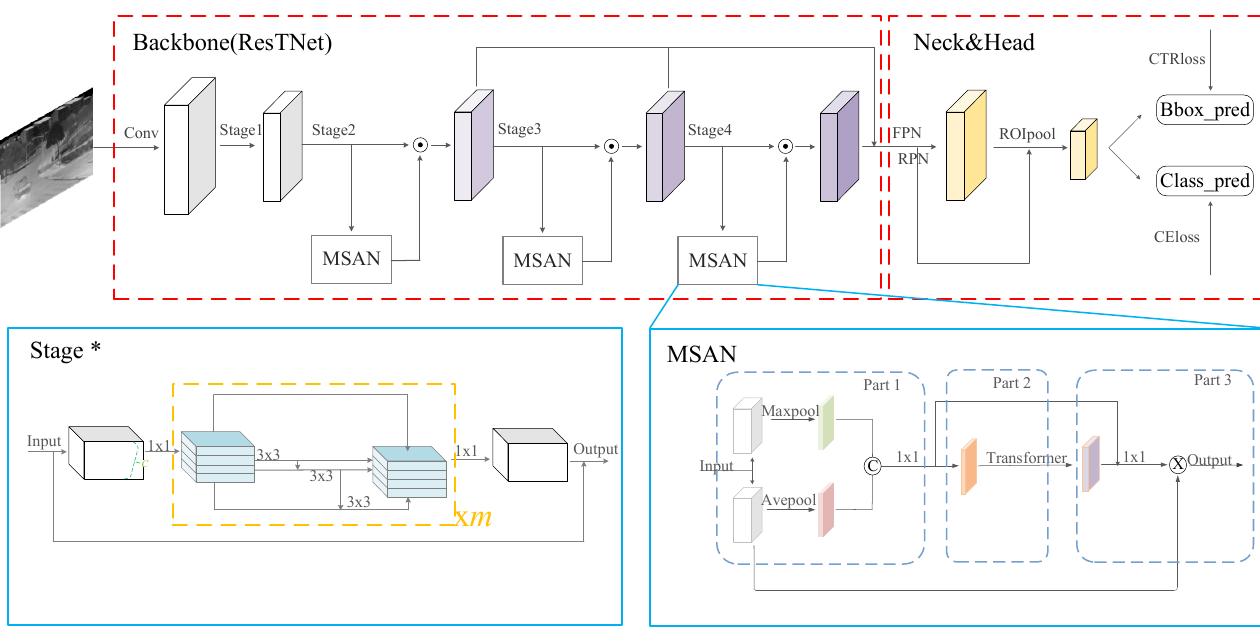
Figure 1. The overall scheme of the proposed method. The part marked with 1 by 1 (3 by 3) denotes convolution as the same size before and after input using kernel size 1 (3). The intersection part of the arrow represents the element addition operation between tensors.